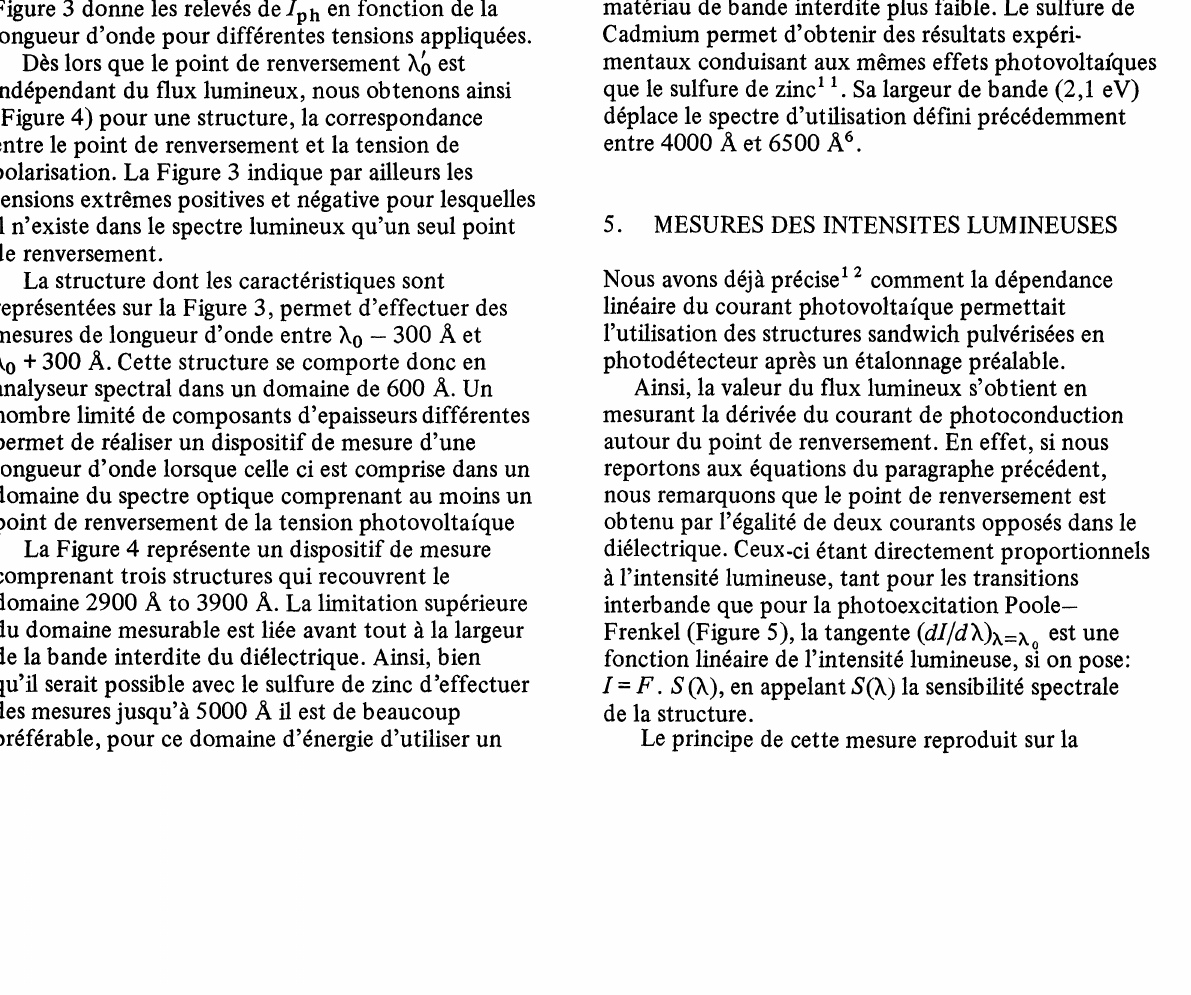
FIGURE 4 Variation de la longueur d’onde de renversement du courant photo61ectrique avec la tension appliqu6e pour trois structures d’6paisseur (1) 180 A (2) 280 A (3) 450